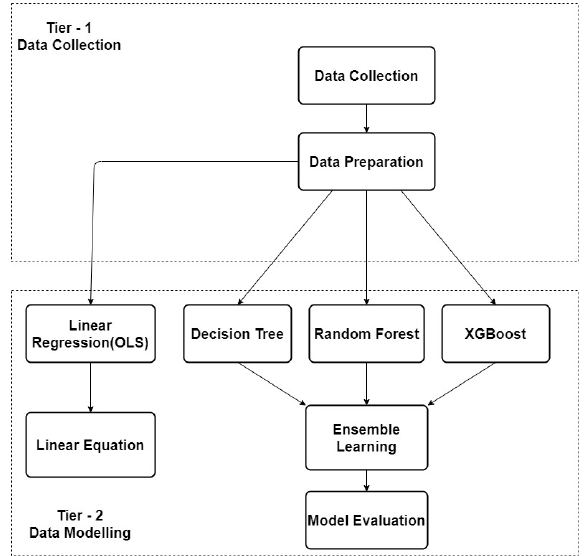
Figure 1. Overview of research